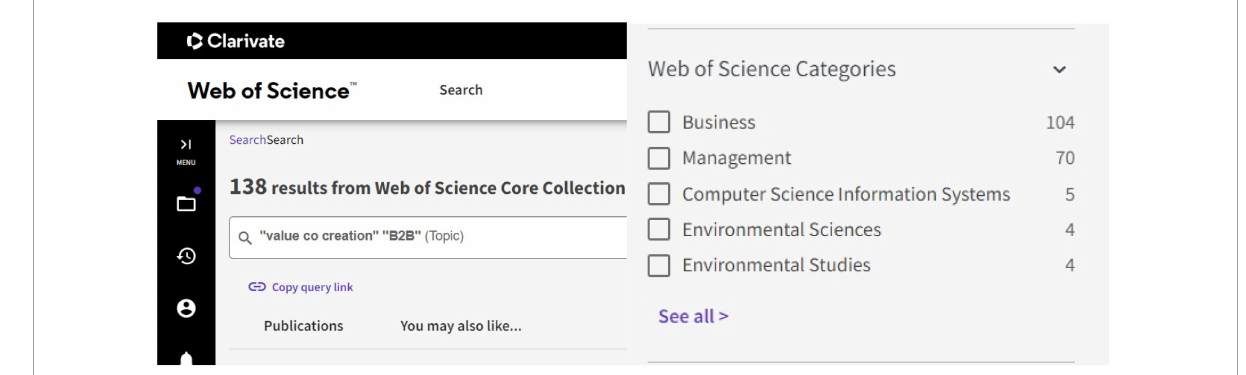
FIGURE1 Total publications. Reproduced with permission of